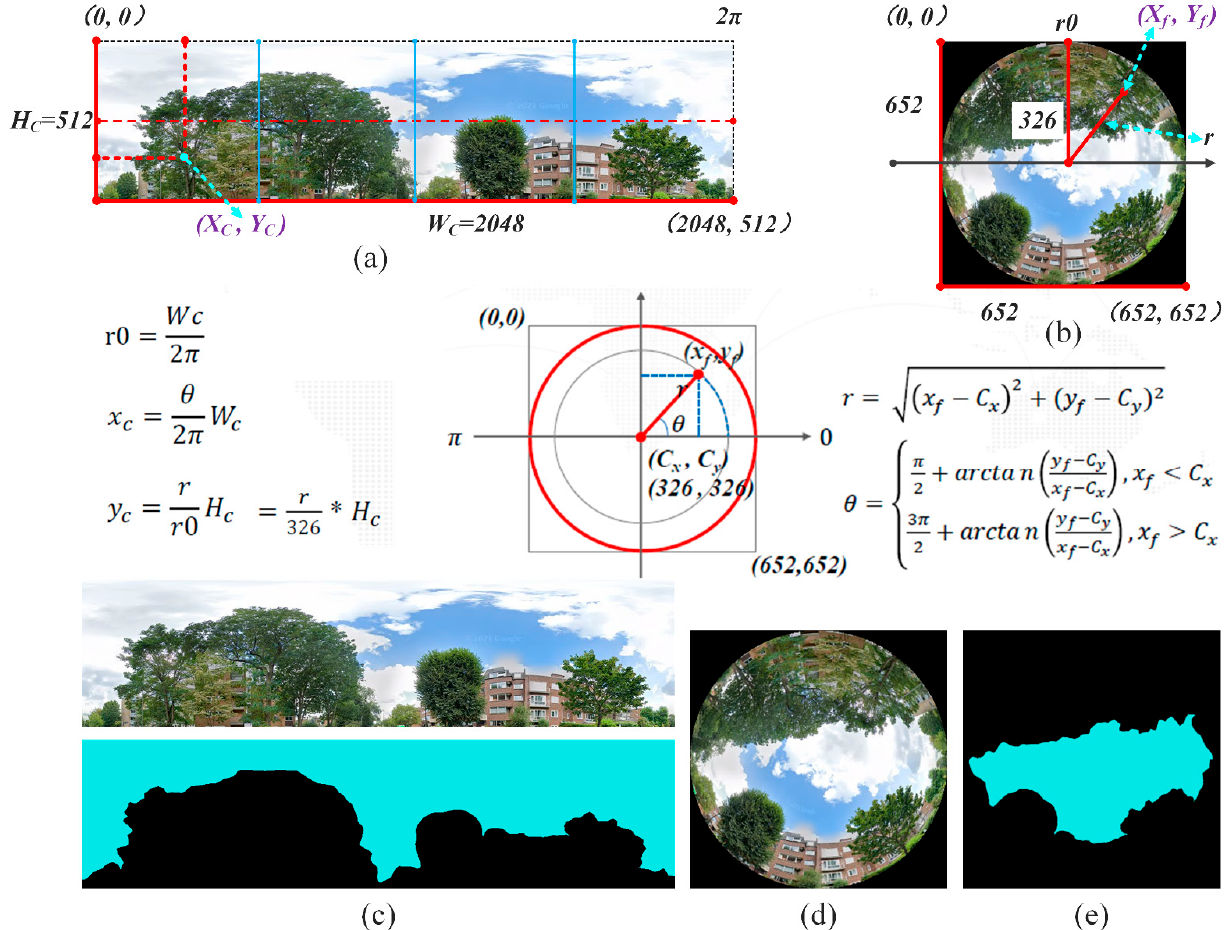
Figure 5. Calculate SVF. ( a , b ) The calculation process to generate a fisheye image; ( c ) the original image and the semantic segmented image of part of the sky; ( d ) the fisheye image generated using a Python script; ( e ) the pixels of the sky in the fisheye image that were extracted.